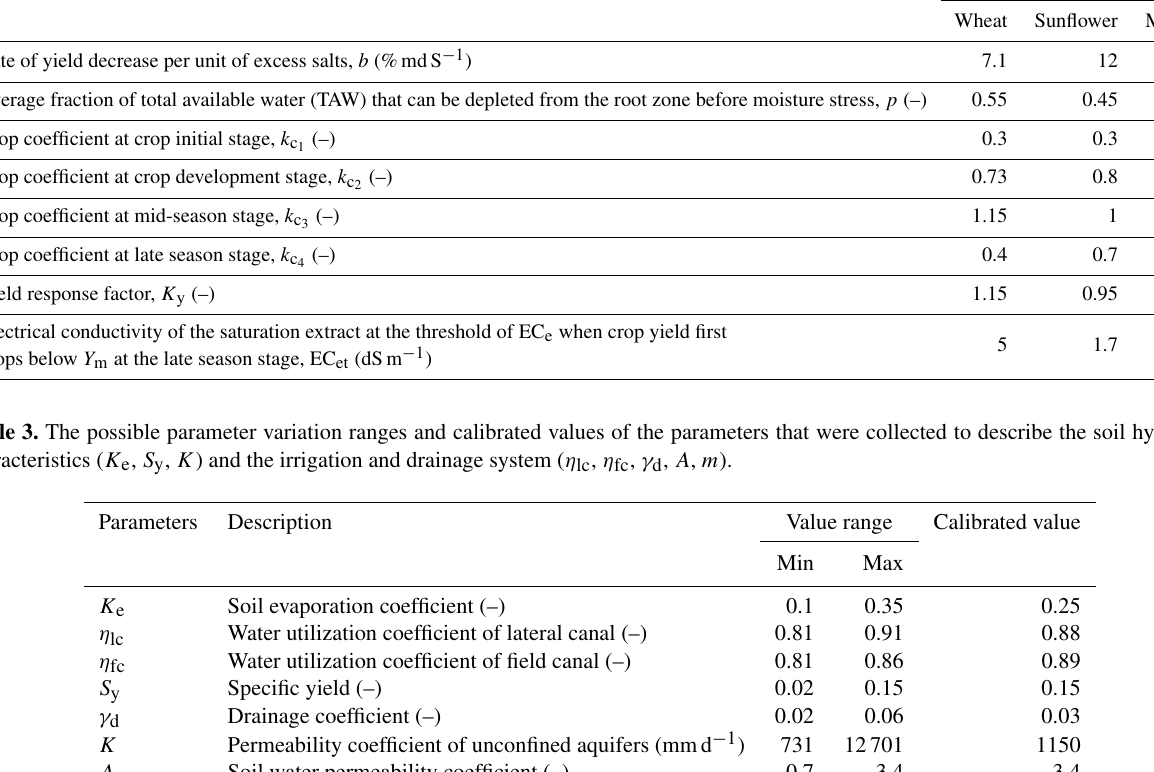
Table 2. Calibrated crop parameters for wheat, sunflower, and maize for the regional irrigation water productivity model. Parameters